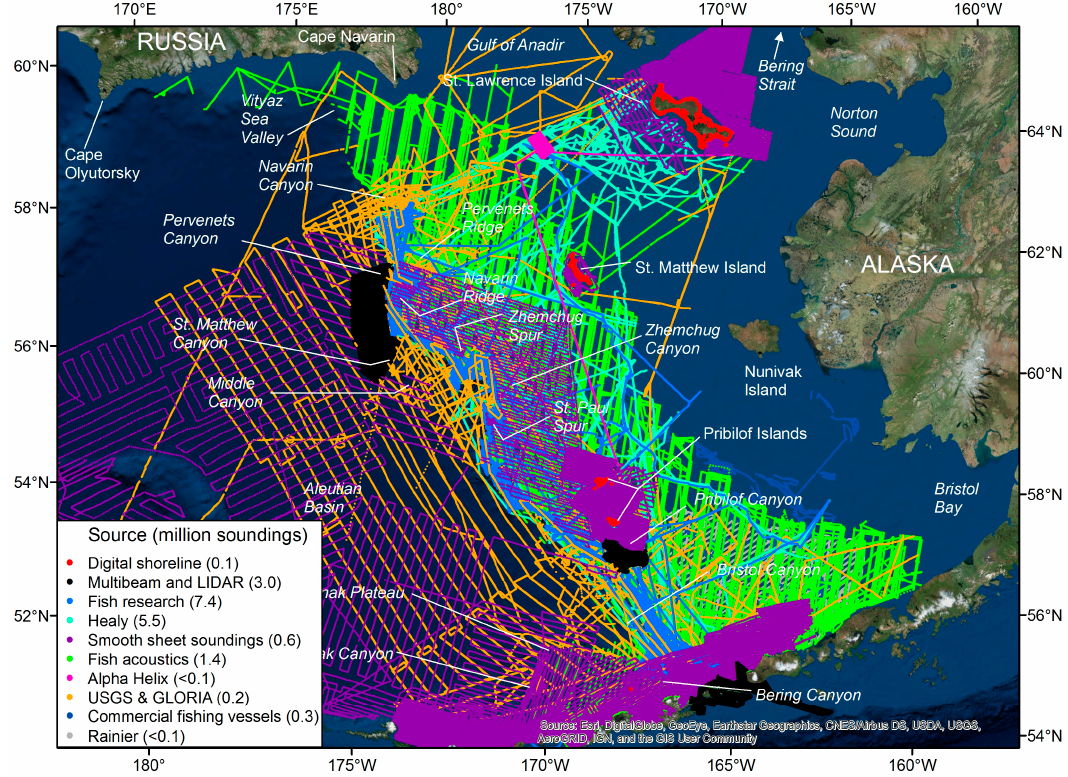
Figure 4. Sources of bathymetry data used in this EBS slope compilation.